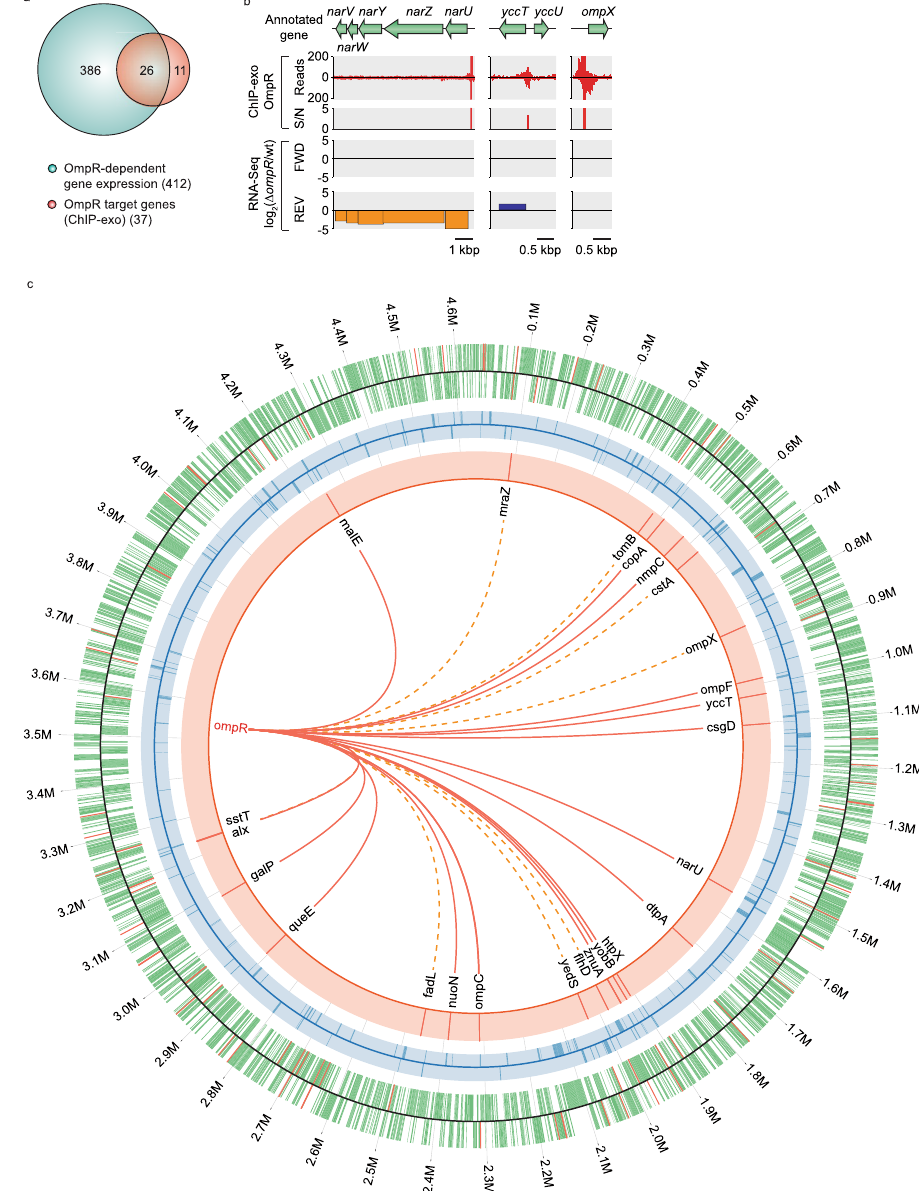
Figure 2. Regulatory causation in OmpR regulon. ( a ) Causal relationships between direct associations of OmpR and changes in transcript levels of genes. ( b ) Regulatory causation of individual ORFs governed by OmpR in response to osmotic stress. Examples of activation ( narUZYWV ), repression ( yccT ), and not determined (no change in transcript level, ompX ). S/N denotes signal to noise ratio. FWD and REV indicate log 2 relative transcript levels from forward and reverse strands, respectively. ( c ) Genome-wide map of OmpR- binding profile was overlaid with differential transcriptional response to OmpR knockout under osmotic stress. Red, blue, and green denote ChIP-exo, RNA-seq, and annotation, respectively. Solid lines indicate genes with OmpR binding with changes in expression level upon OmpR knock-out. Dotted lines indicate the genes with TF bindings but without changes in expression level upon OmpR knockout. Only the first gene of the operon was shown. The figure was made using Circos version